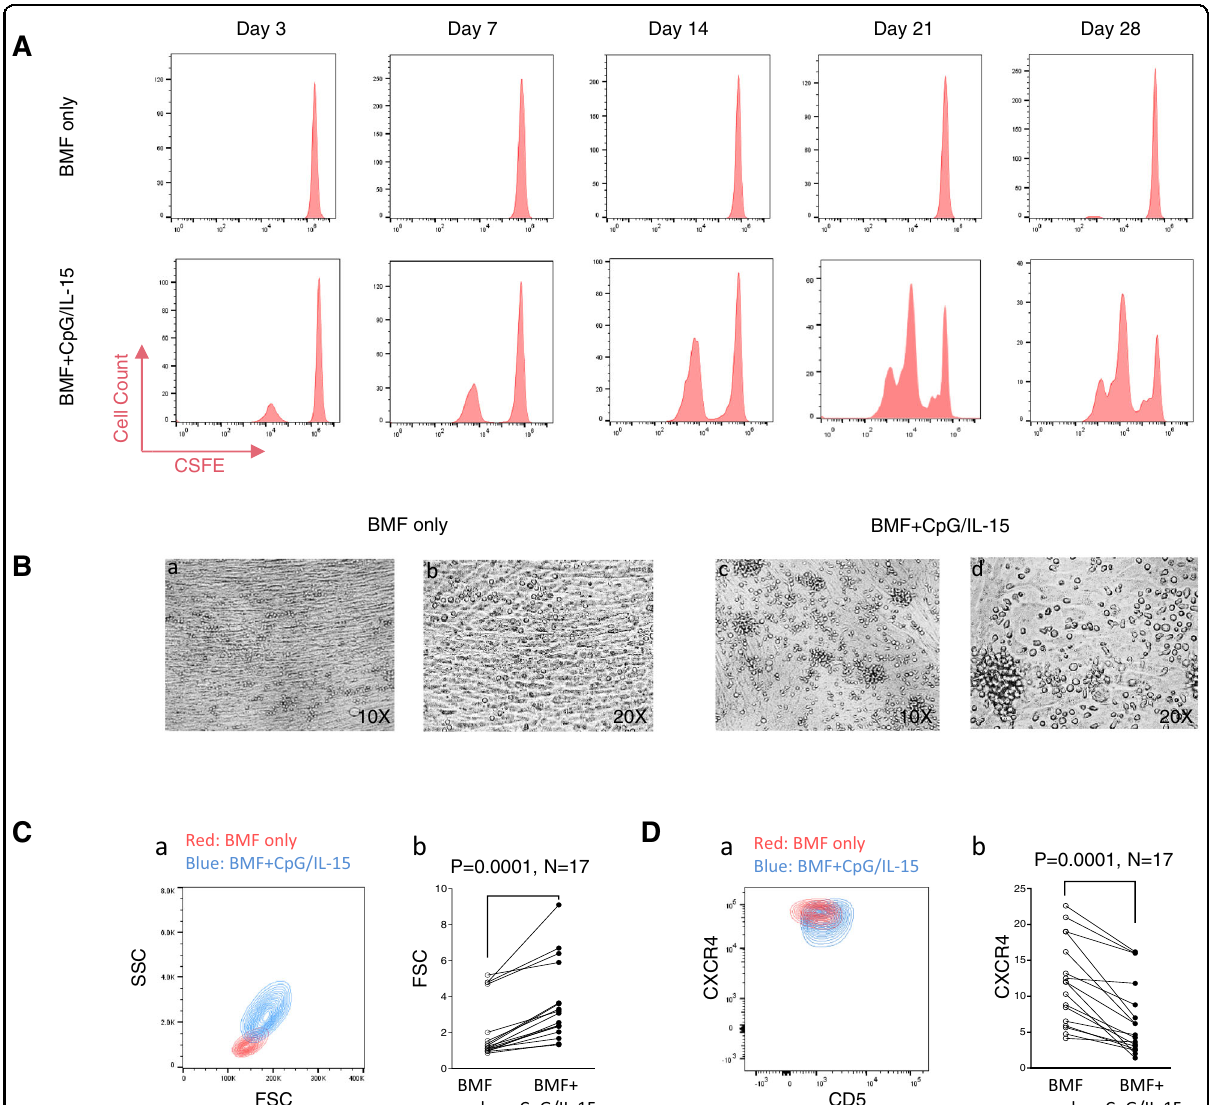
Fig. 1 CLL cells actively divide for a long term in an ex vivo model. Peripheral blood CLL cells from a patient were co-cultured with either BMF alone or with BMF + CpG/IL-15 stimulation. A Cell proliferation analyzed by fl ow cytometry. CFSE-labeled CLL cells were cultured with either BMF alone (upper) or with CpG (2µg/mL) plus IL-15 (10ng/mL) (lower). Duration of culture were indicated. B Light microscopy of CLL cells at Day 7 of the co-culture. CLL cells cultured with BMF alone are single small round cells laying on top of the BMF monolayer (a and b), while CLL cells with CpG/IL-15 stimulation appear larger and clustered (c and d). Microscopic magni fi cations are indicated. C Cell size was determined by forward scatter (FSC) on fl ow cytometry at Day 7 of the co-culture. SSC/FSC contour map between the two culture conditions is shown for one case (a) and for 17 cases (b). D Cell surface CXCR4 was measured by fl ow cytometry at Day 7 of the co-culture. CXCR4/CD5 contour map between the two culture conditions is shown for one case (a) and for 17 cases